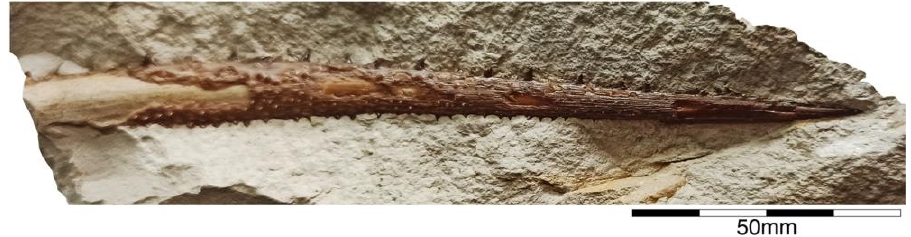
Figure 2. Dorsal fin spine of the myriacanthoid, † Chimaeropsis ? franconicus (BT 5160.00) from the early Tithonian? (Upper Jurassic) of Streitberg near the castle ruin of Rabenstein.